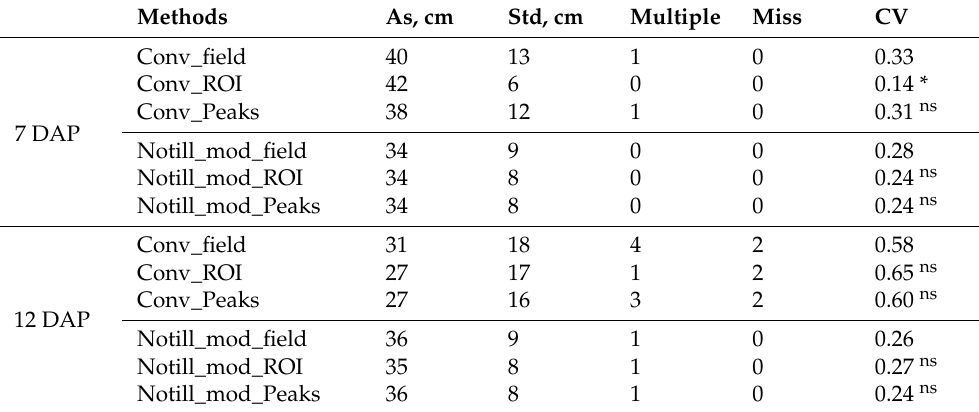
Table 2. Descriptive statistics, specific planting metrics, and CV in all